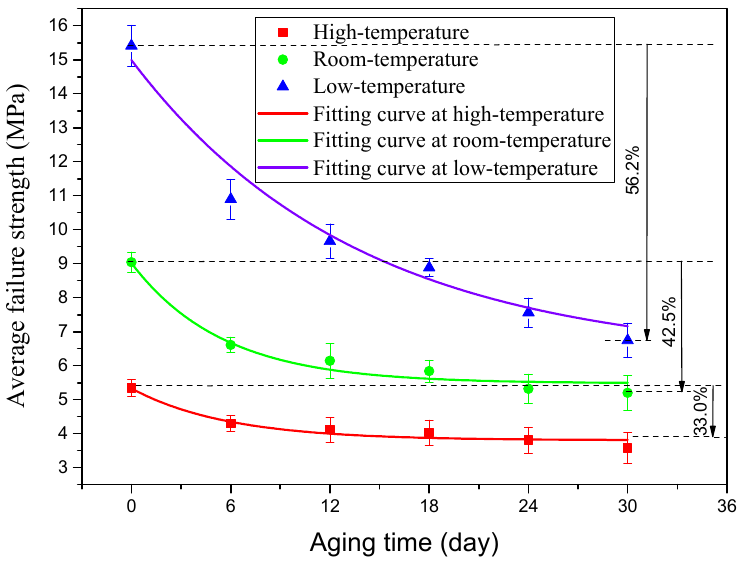
Figure 11. Fitting curves of average failure strength of TASJ. Table 3. Fitting function expressions and fitting accuracy R 2 .